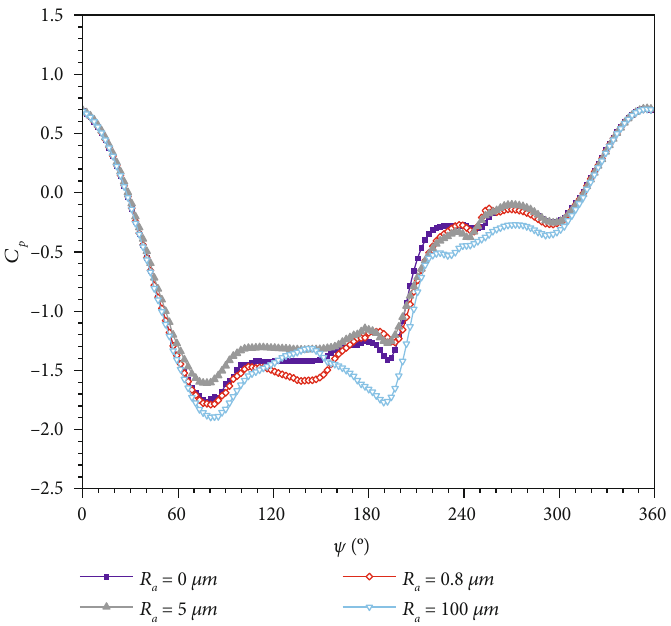
Figure 37: Pressure coe ffi cient distribution of di ff erent models at 4 D .